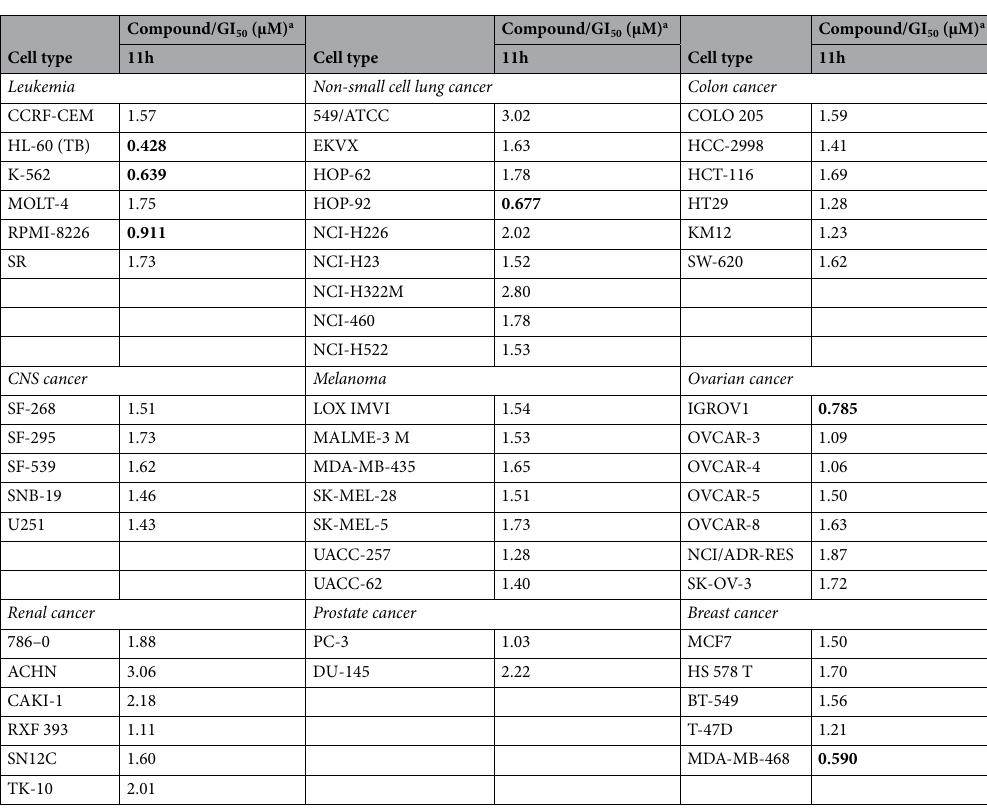
Table 4. Results of the 5-dose in vitro human cancer cell growth inhibition (data obtained from NCI’s in vitro 60 cell 5-dose screening) assay for compound 11h . a GI 50 —the molar concentration of tested compound causing 50% growth inhibition of tumor cells. Determined at five concentration levels (100, 10, 1.0, 0.1 and 0.01 μM); The most active compounds are highlighted in